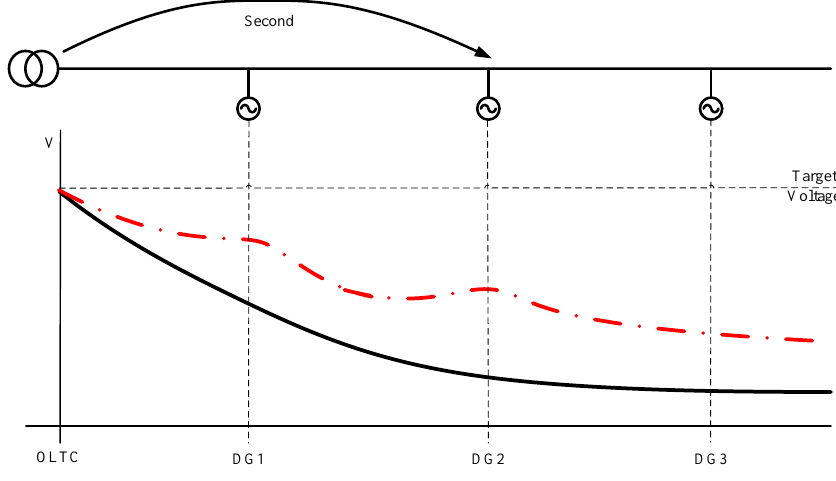
Figure 6. Voltage profile by reactive power of DG1 and DG 2.